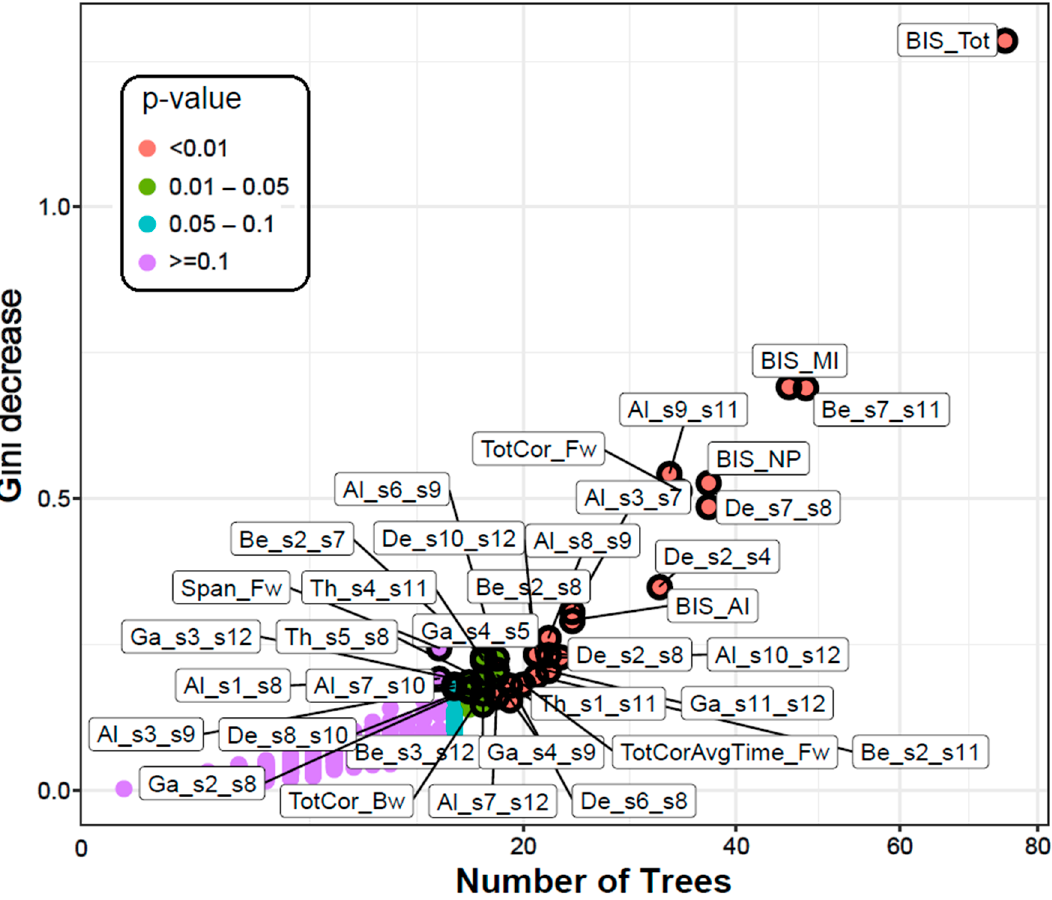
Figure 2. The multi-way importance plot showing the top significant variables (labelled and marked with black circles) that contributed to the classification of alcohol use disorder from control individuals based on the measures Gini decrease, number of trees, and p-value . All 4 impulsivity scores, 29 FC connections, and 3 neuropsychological variables were significant (circled and labelled red and gray dots). Impulsivity scores stood on top in the importance list. Note that the variables that were not significant or important (purple dots) are not highlighted. [Abbreviations in the FC variable